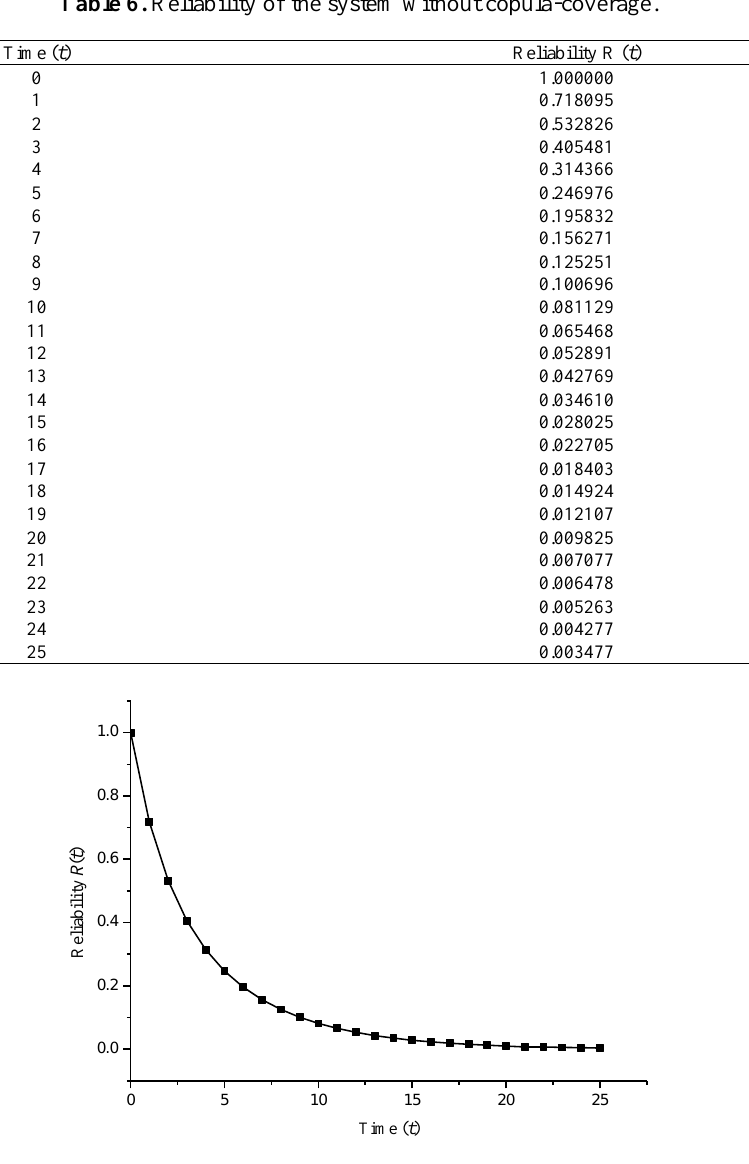
Figure 6. Reliability of the system without copula